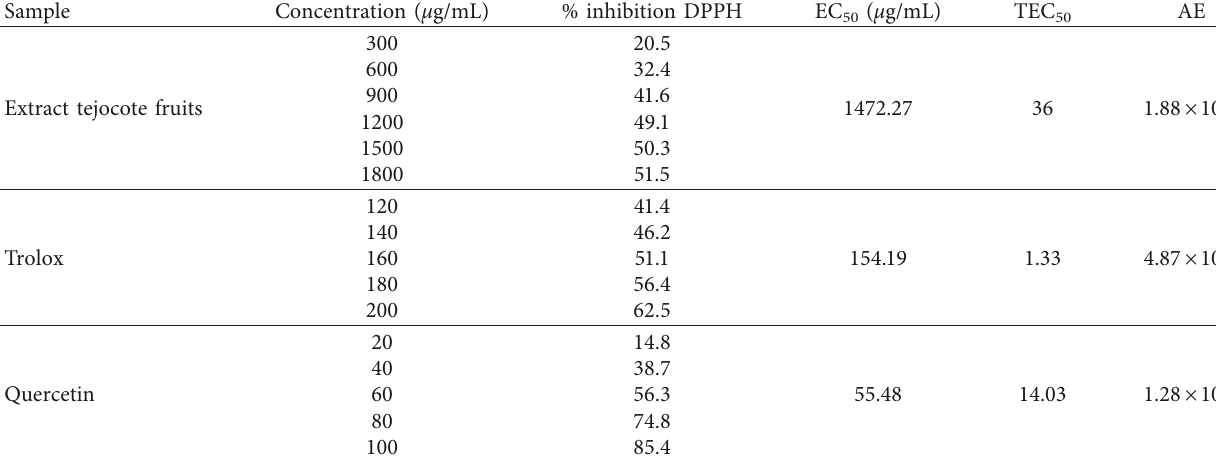
Table 2: Antioxidant activity through the DPPH radical.